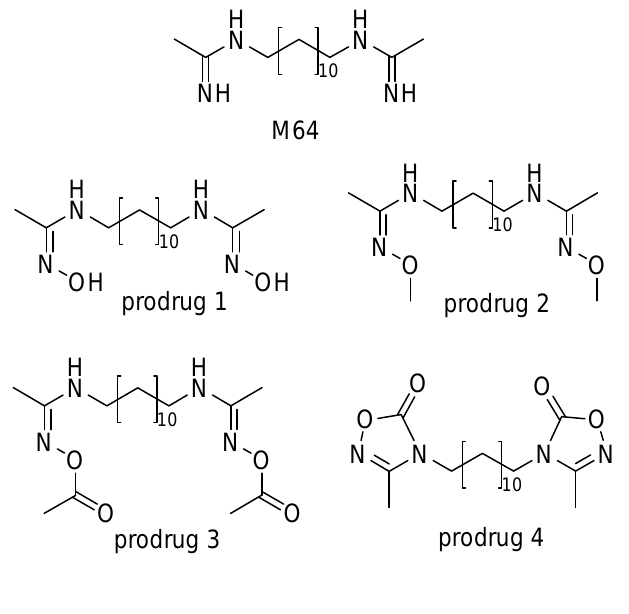
Figure 29. Chemical structures of compound M64 and its prodrugs.